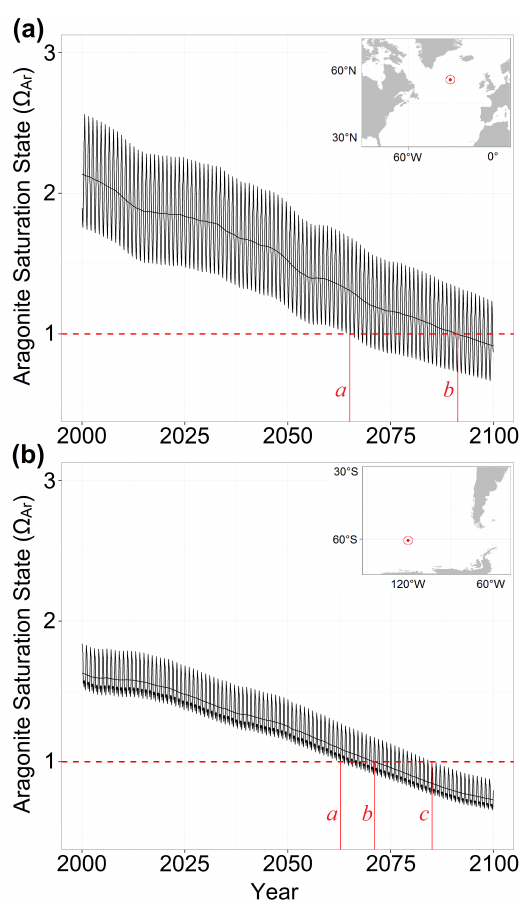
Figure 6. Future aragonite undersaturation states ( (cid:127) Ar ) at locations in the (a) North Atlantic and (b) Southern Ocean under the business- as-usual scenario (RCP8.5). The influence of seasonal variability accelerates undersaturation conditions by 27 and 8 years relative to annual-mean estimates (black line) in the North Atlantic and South- ern Ocean respectively. The red points a , b , and c denote the time when month-long, annual-mean and permanent undersaturation oc- curs